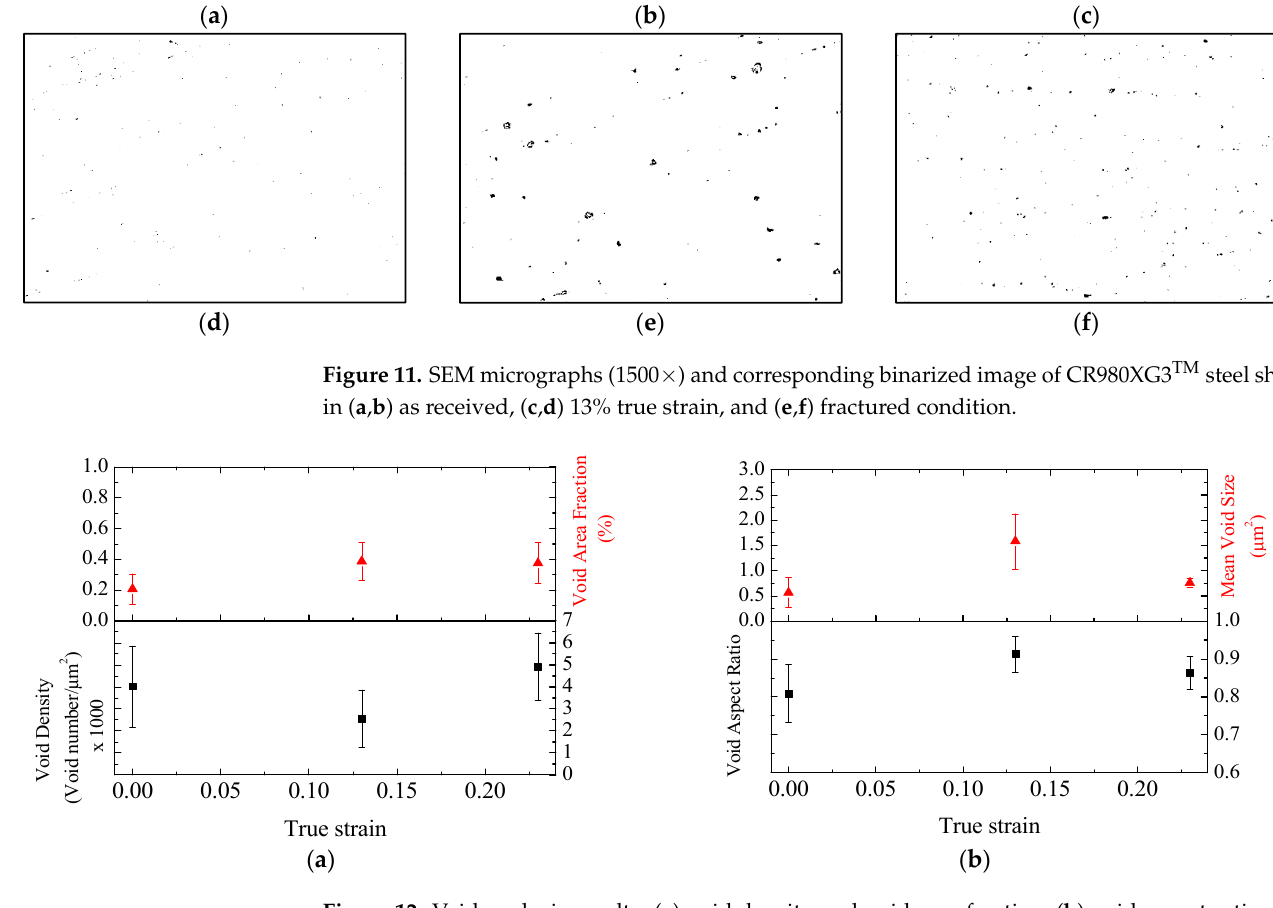
Figure 12. Void analysis results: ( a ) void density and void area fraction, ( b ) void aspect ratio and mean void size.